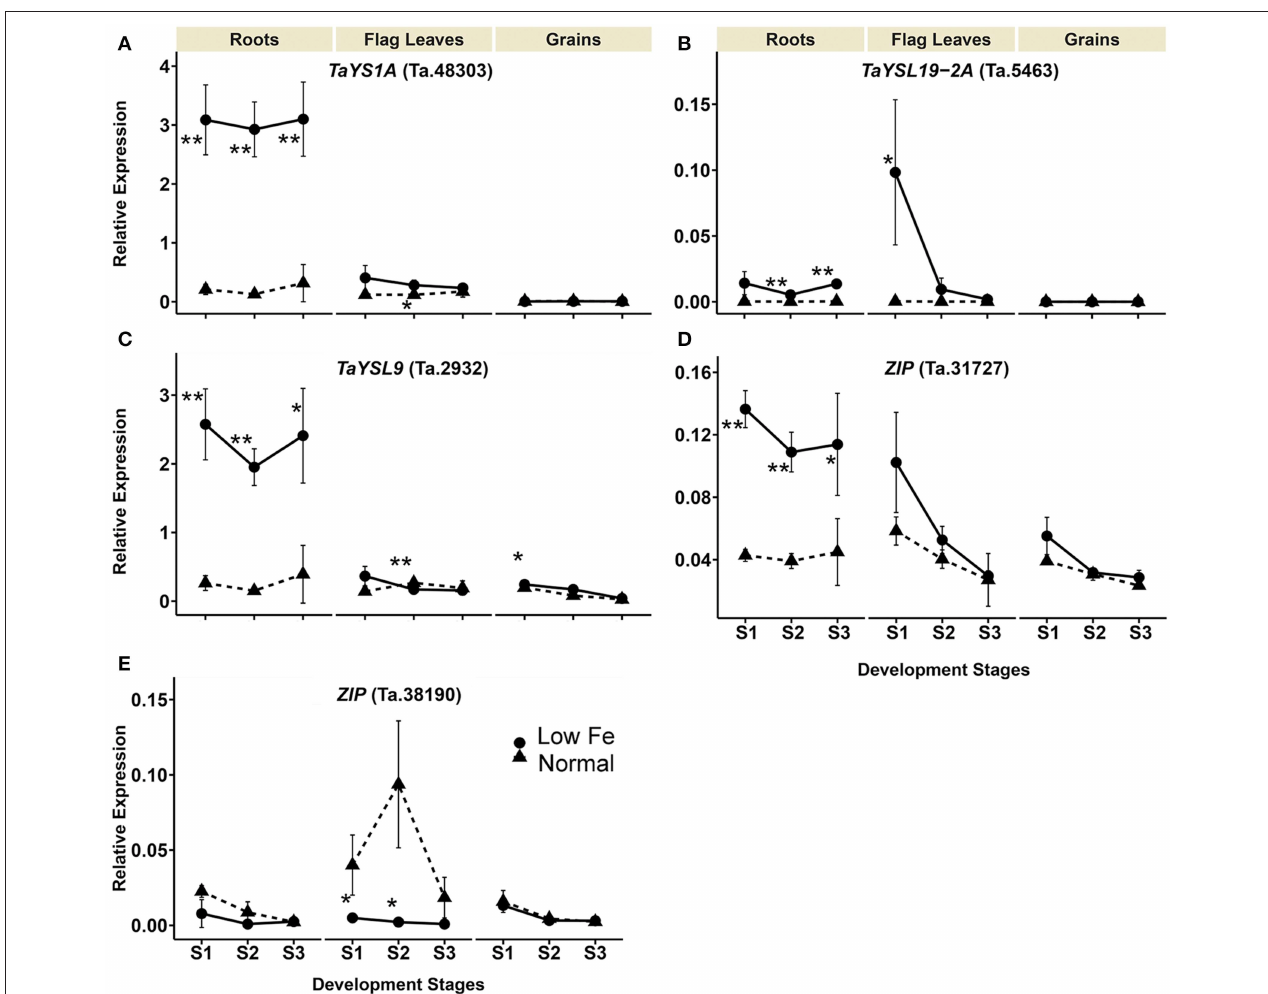
FIGURE 3 | Iron deficiency triggered expression differences of wheat homologs of long-distance iron transporters encoding genes. The data collected at three different development stages, i.e., 8–10 DPA (stage 1), 25–28 DPA (stage 2), and 33–35 DPA (stage 3) are presented. Values are the mean ± standard deviation of the three biological replicates (* p ≤ 0.05; ** p ≤ 0.01). Note the differences in scale at Y-axis for relative expression levels of tested genes. (A) TaYS1A (Ta.48303), (B) TaYSL19 -2A (Ta.5463), (C) TaYSL9 (Ta.29321), (D) ZIP (Ta.31727), (E) ZIP